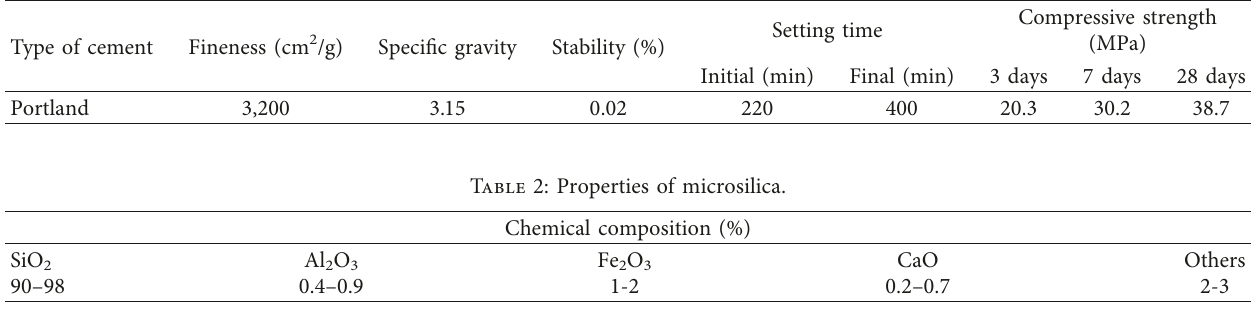
Table 1: Properties of cement [34].